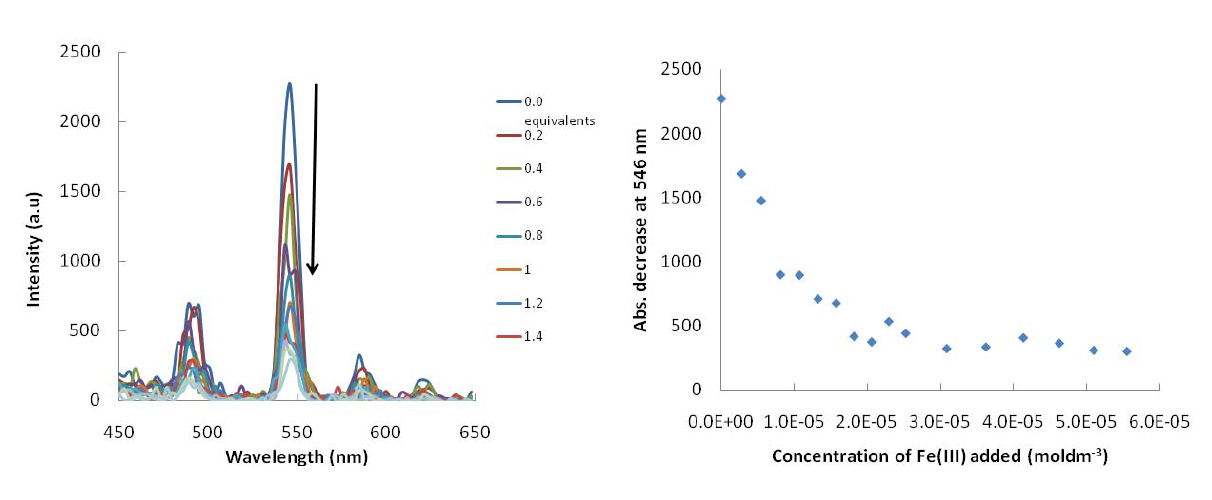
(0 to 5 equivalents) MeOH:H 3